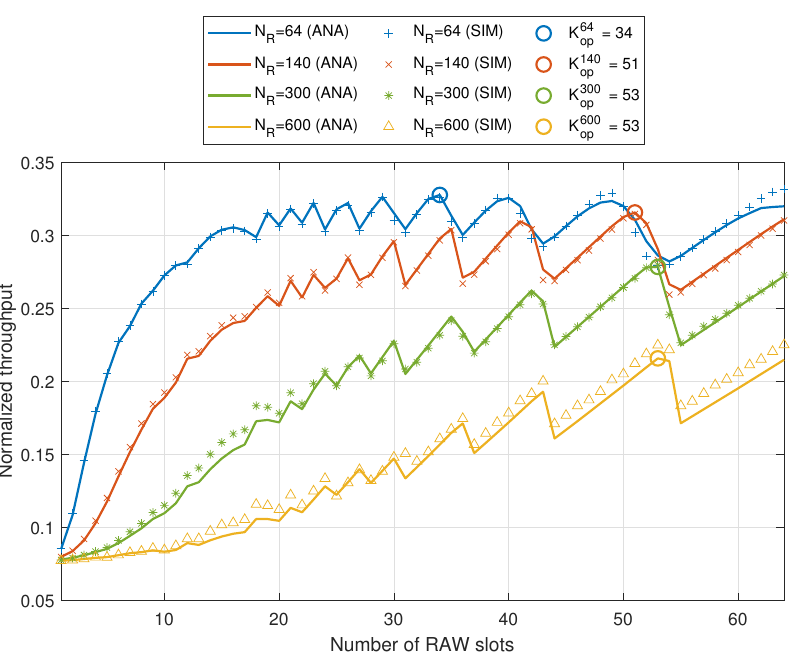
Figure 14. RAW throughput in terms of allocated RAW slots for different sets of assigned